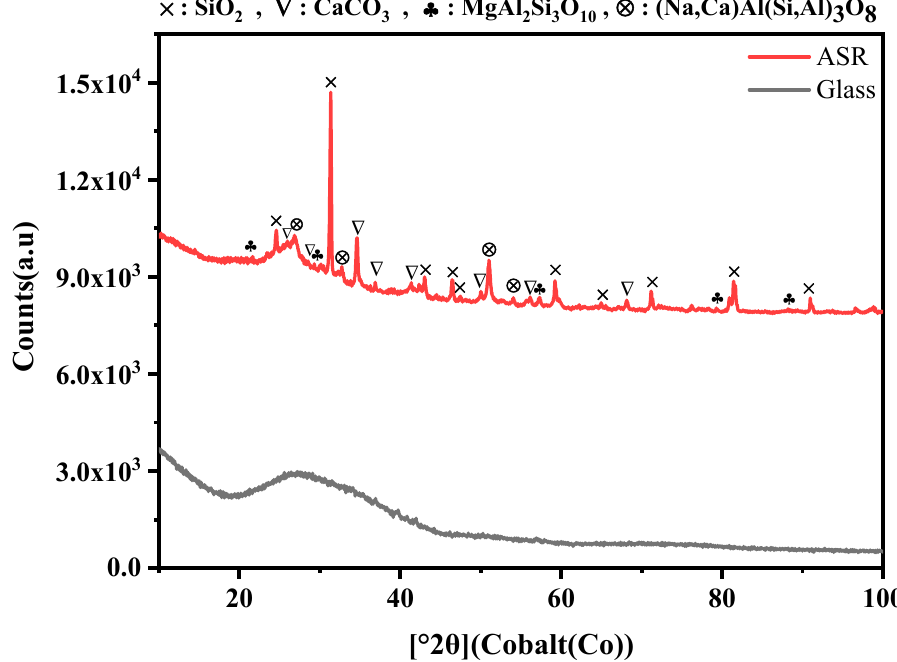
Figure 5. XRD spectrums of the mixed plastics of ASR and glass.